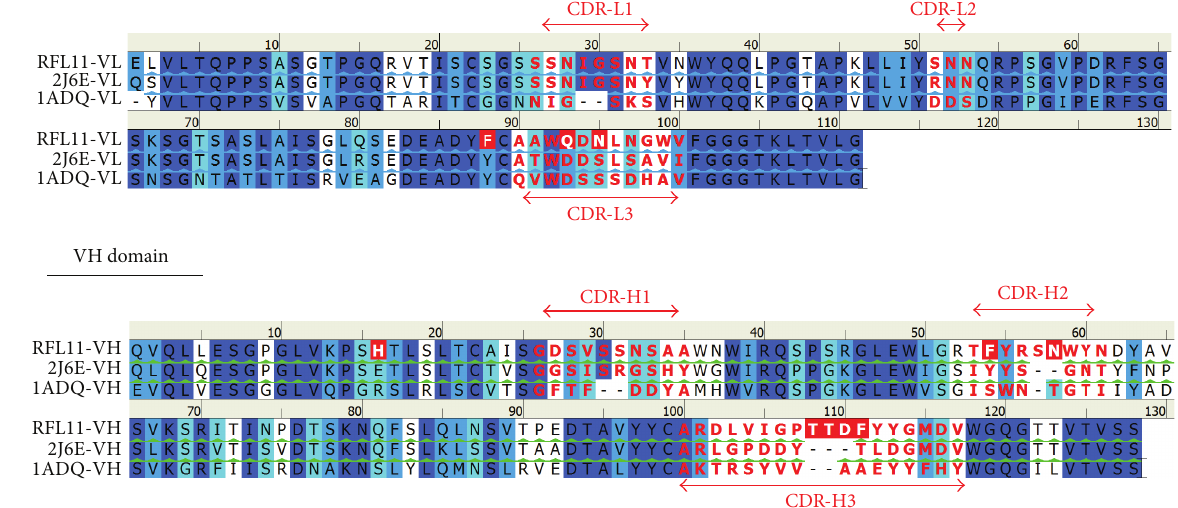
Figure 6: Multiple sequence alignment of variable domains of the light and heavy chains of RFL11 with 2J6E and 1ADQ antibodies. The background of the residues is colored according to sequence similarity. Deep blue color shows conserved residues in all sequences. The color scheme is from deep blue and light blue to cyan corresponding to identify highly and low conserved residues, respectively. The residue backgrounds colored white are not similar. Residues of somatic mutation of RFL11 have a red background. Residues of the CDRs are indicated by bold letters in red.